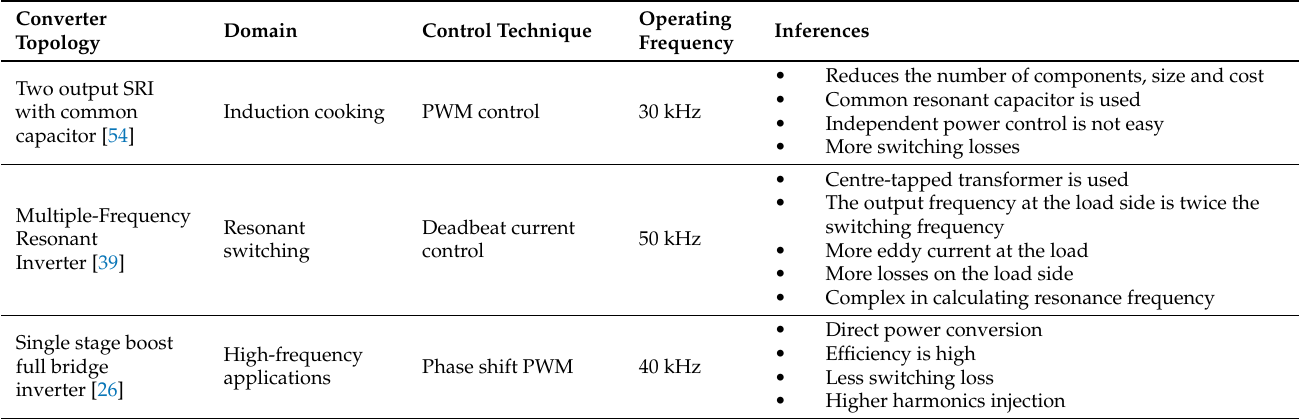
Table 7. Recent research connected to household